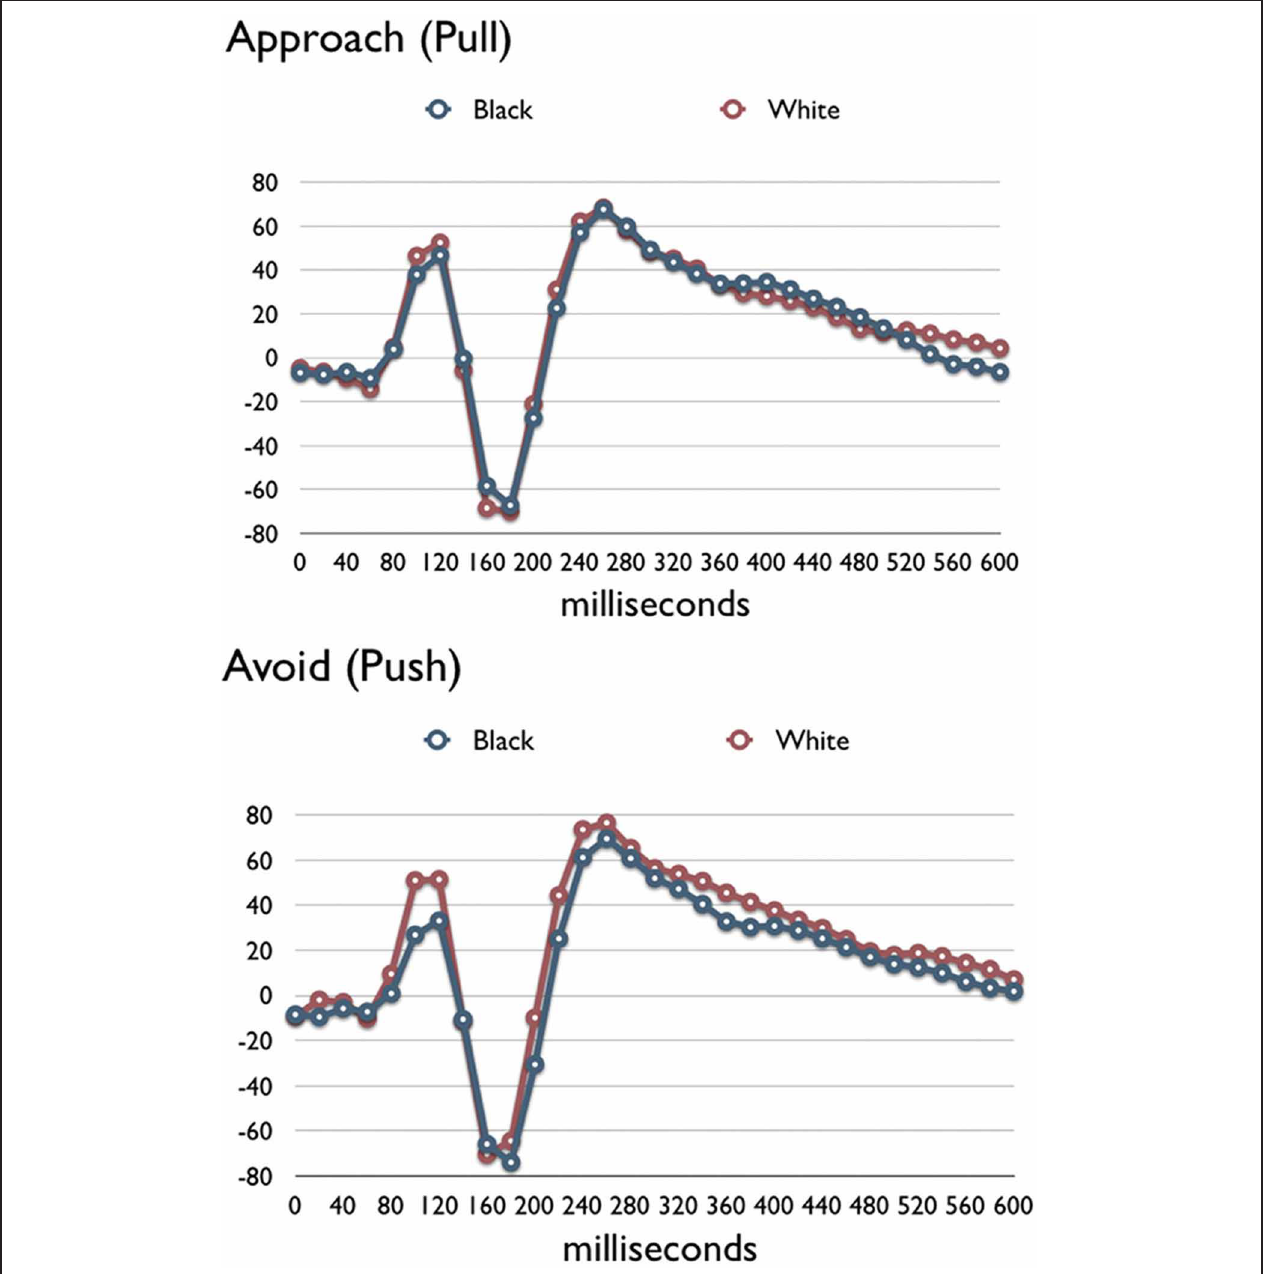
FIGURE 2 | Latent time courses for Black and White faces in the Pull and Push conditions. Because these values are projected from latent space, values on the y axis are scaled in arbitrary units with respect to underlying microvolts.